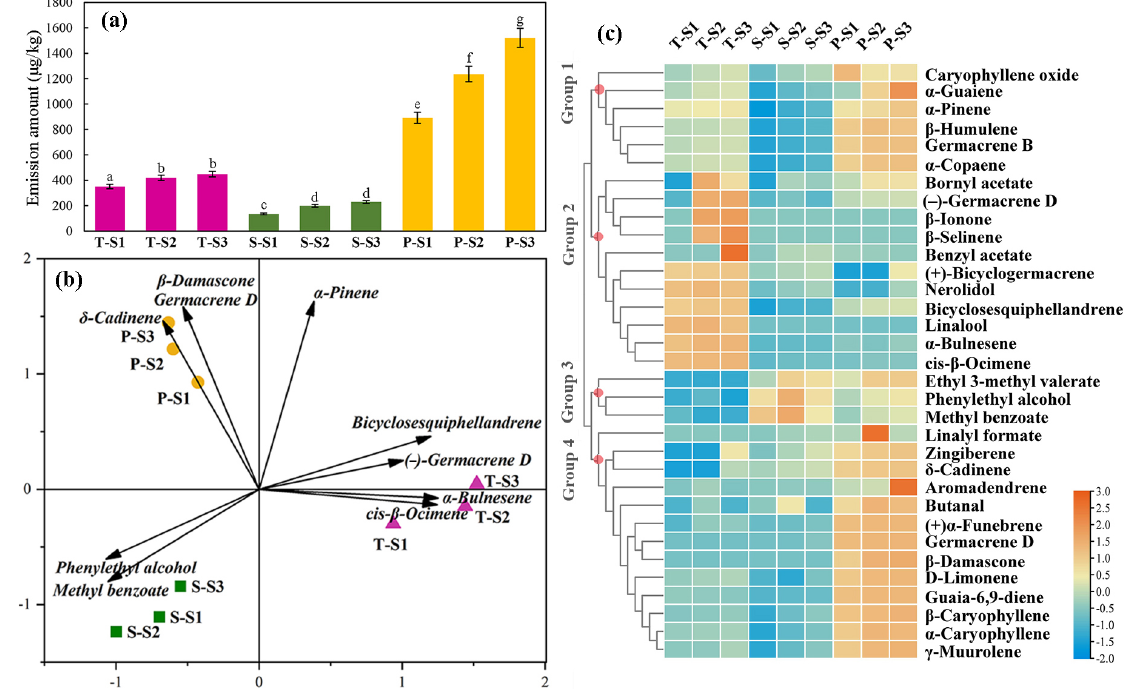
Figure 3. Spatiotemporal analysis ( a ), heatmap and hierarchical cluster analysis ( b ) and principal component analysis ( c ) of the emission amounts of the main floral aroma compounds of M. crassipes . Values are mean ± SD of three replicates. Different letters of flower length indicate a significant difference ( p < 0.05). (T: tepals; S: stamens; P: pistil; S1: bud stage; S2: initial flowering stage; S3: full flowering